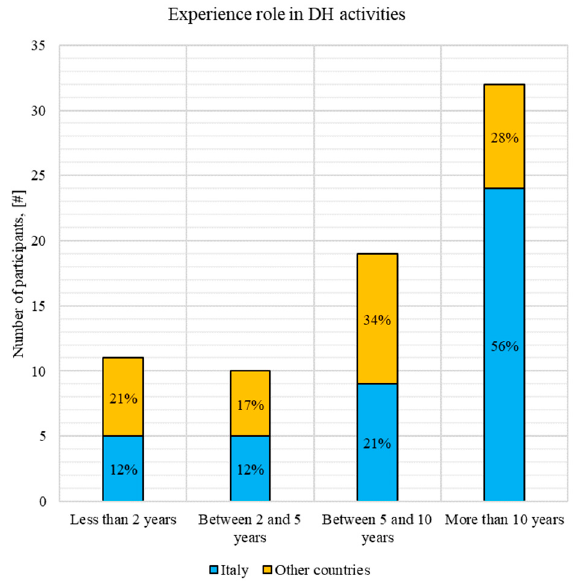
Figure 6. Number of survey participants as a function of experience in DH systems.